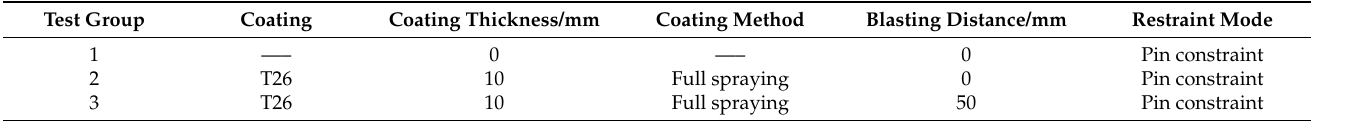
Figure 3. Schematic diagram of explosion experiment setup. Table 2. Explosion test conditions.